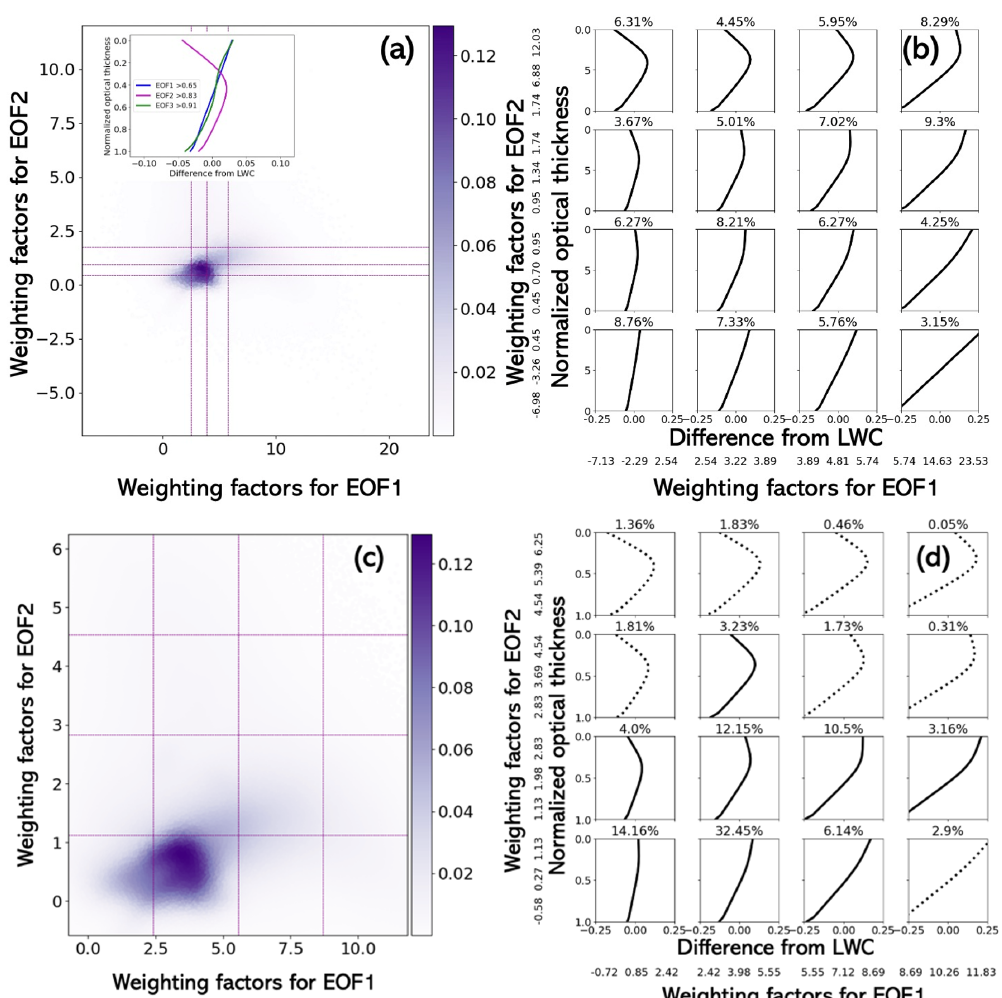
Figure 4. (a) Density plot of EOF1 and EOF2 weighting factors for all LWC profiles. The color scale corresponds to the density of the points in percent, and the purple dotted line indicates quartile boundaries along the x and y axes. The inset in (a) illustrates the first three dominant EOFs. They explain the 91% of variance among all 1040668 samples. (b) Cloud LWC profiles reconstructed from EOF1–3 according to quartile bins in (a) ; the black dotted and solid lines denote the profiles that represent fewer than and more than 3% of the samples, respectively. (c) Same as (a) but without weighting factors exceed the 99th percentile or less than the 1st percentile and with the purple dotted line indicating the arithmetic mean boundaries. (d) Same as (b) , but the reconstruction is based on bins in (c)